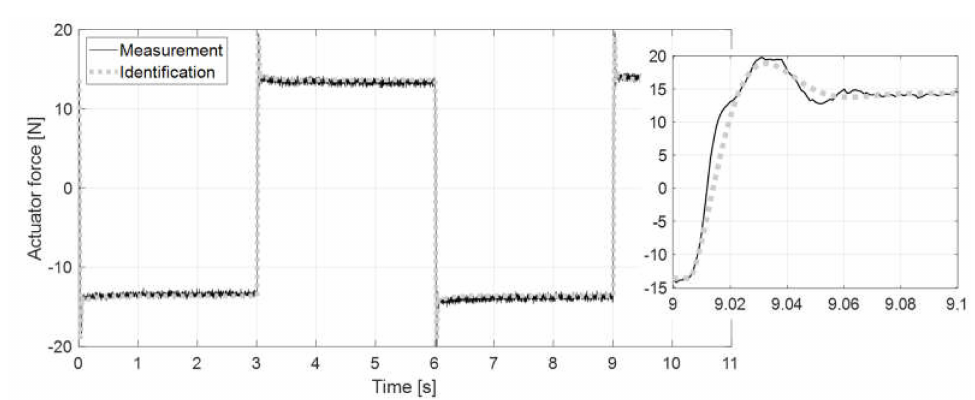
Figure 5. Electric drive force step response series: measurement vs.